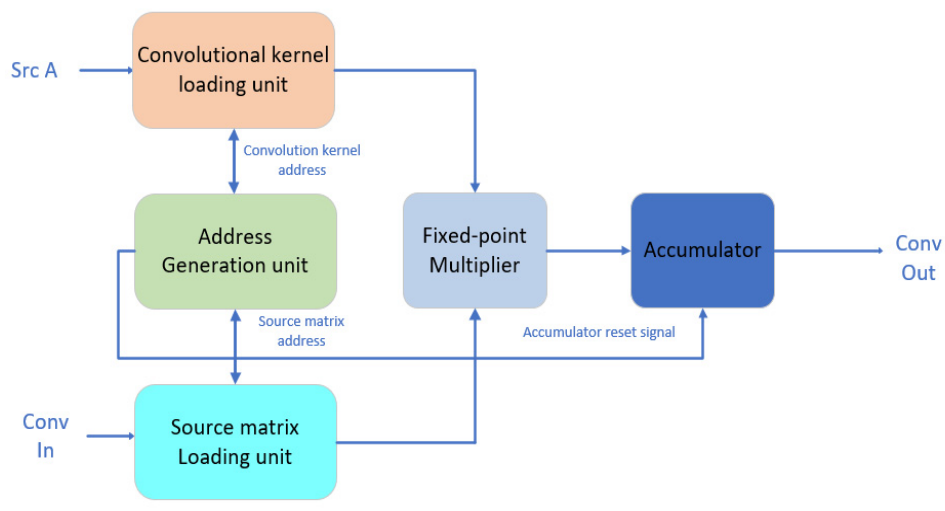
Figure 5. Structure of the convolutional operation circuit.